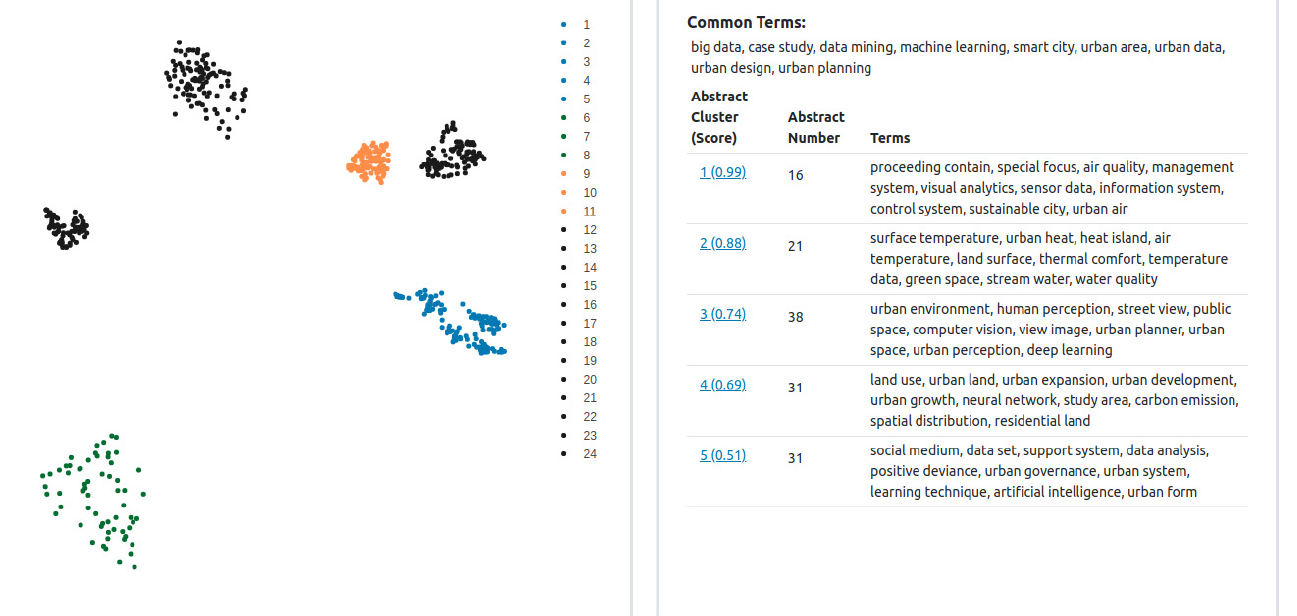
Figure 5. Abstract cluster visualization for all clusters from the iterative clustering phase. On the left, the scatter chart of abstract vectors reveals three color regions (blue, orange, and green) along with three gray regions for outliers. Clicking on the blue region retrieves and displays the abstract clusters in the right panel.